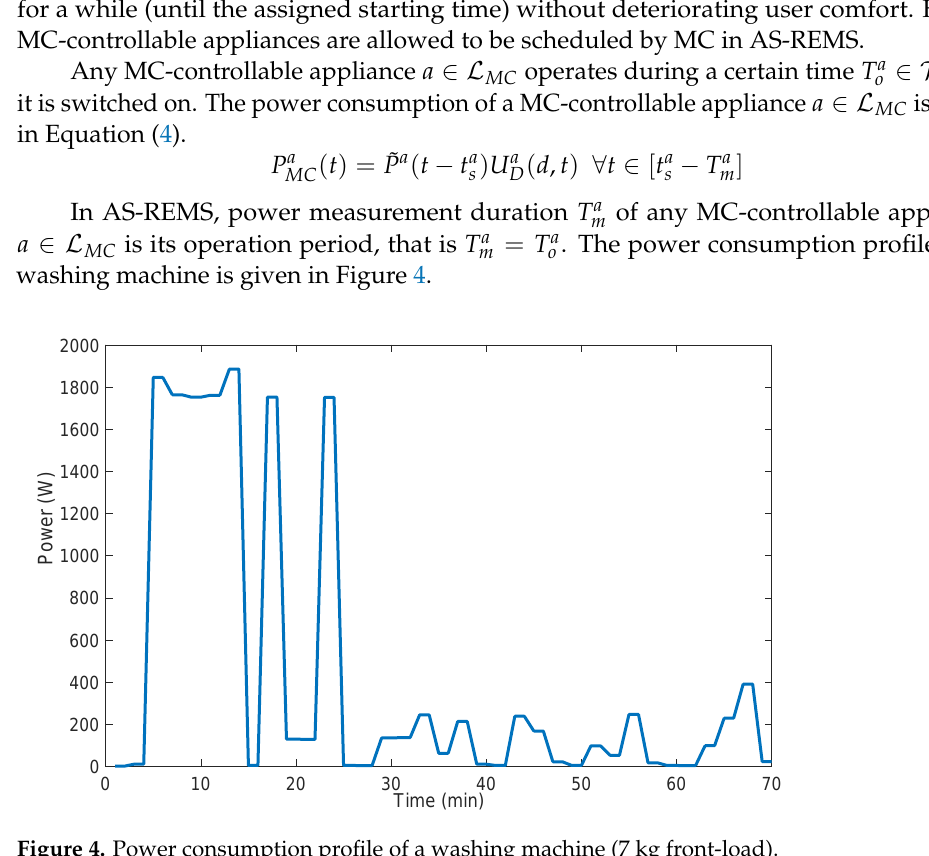
Figure 4. Power consumption profile of a washing machine (7 kg